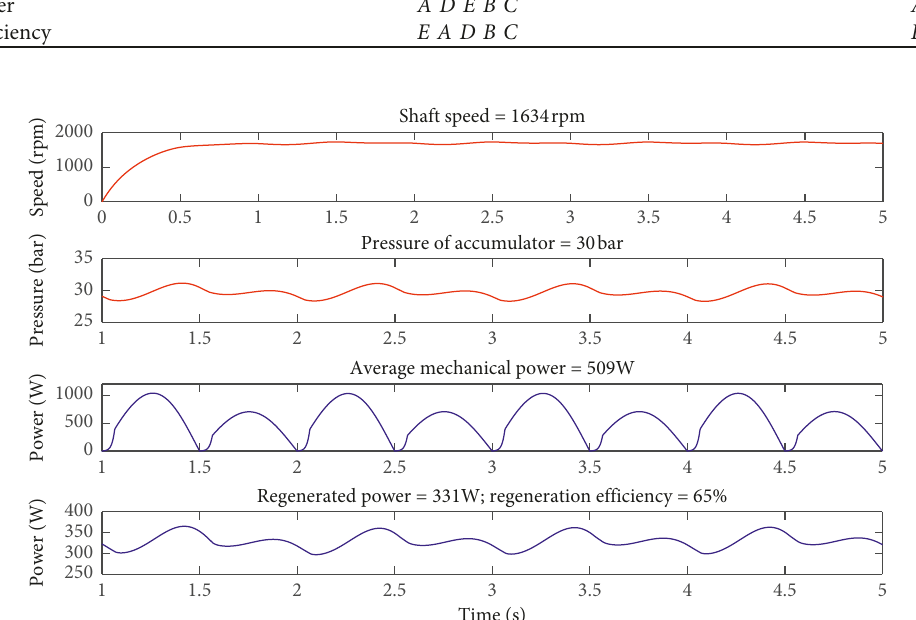
Figure 10: The results with optimal parameter combinations.